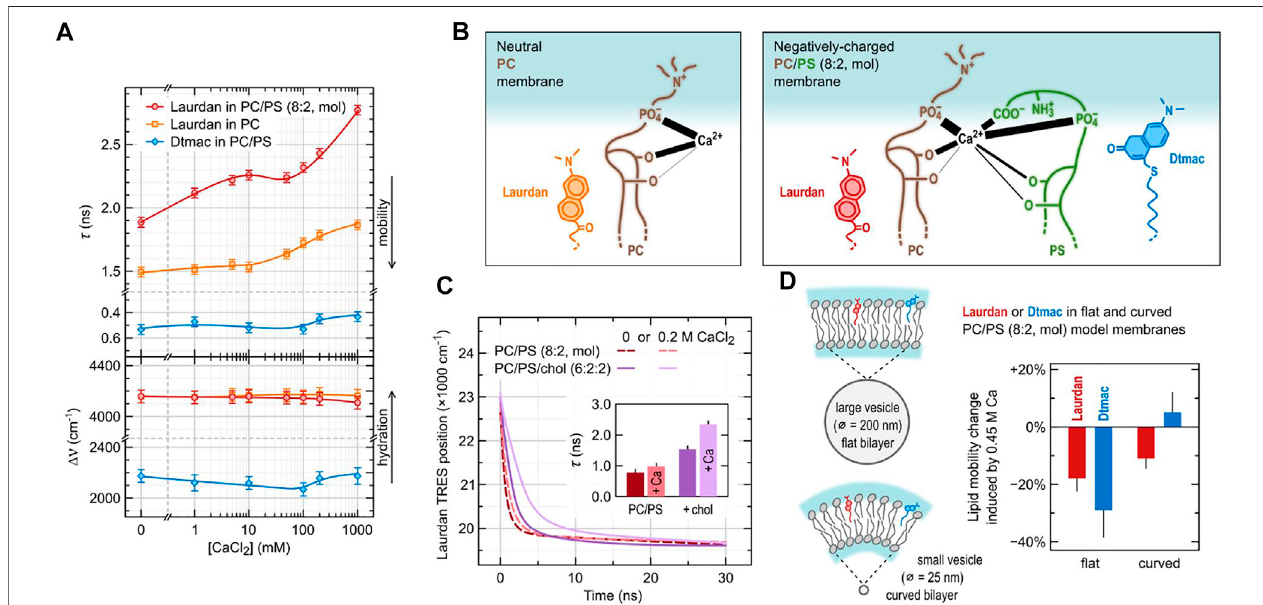
FIGURE 3 | Adsorption of calcium ions to model lipid membranes investigated using TDFS. (A) depicts TDFS parameters obtained for unilamellar liposomes composed of either pure phosphatidylcholine (PC) or its mixture with 20 mol% phosphatidylserine (PS) dispersed in CaCl 2 solutions. Laurdan and Dtmac were used to probe lipid carbonyl and phosphate regions, respectively. (B) summarizes the complex calcium interactions with phospholipids as obtained from the joined molecular dynamicsand experimental study(Melcrováet al.,2016).Positions ofthefunctionalgroupsoflipids aretakenfrom density pro fi les obtained inmolecular dynamics simulations.ThethicknessoftheblacklinesjoiningthefunctionalgroupswithCa 2+ correspondstothemeannumberofcontactsbetweenthem. (C) showsthein fl uence ofcholesterol(chol)onthecalciumadsorptiontoPC/PSmodelmembranes.TheresultsincludethepositionofthemaximaofTime-ResolvedEmissionSpectra(TRES)of Laurdan together withmeanrelaxation times (inside) obtainedfor PC/PS (8:2) and PC/PS/chol(6:2:2) lipid compositionin theabsenceand in the presence ofCaCl 2 . (D) presents the effect of PC/PS membrane curvature on the adsorption of Ca 2+ .